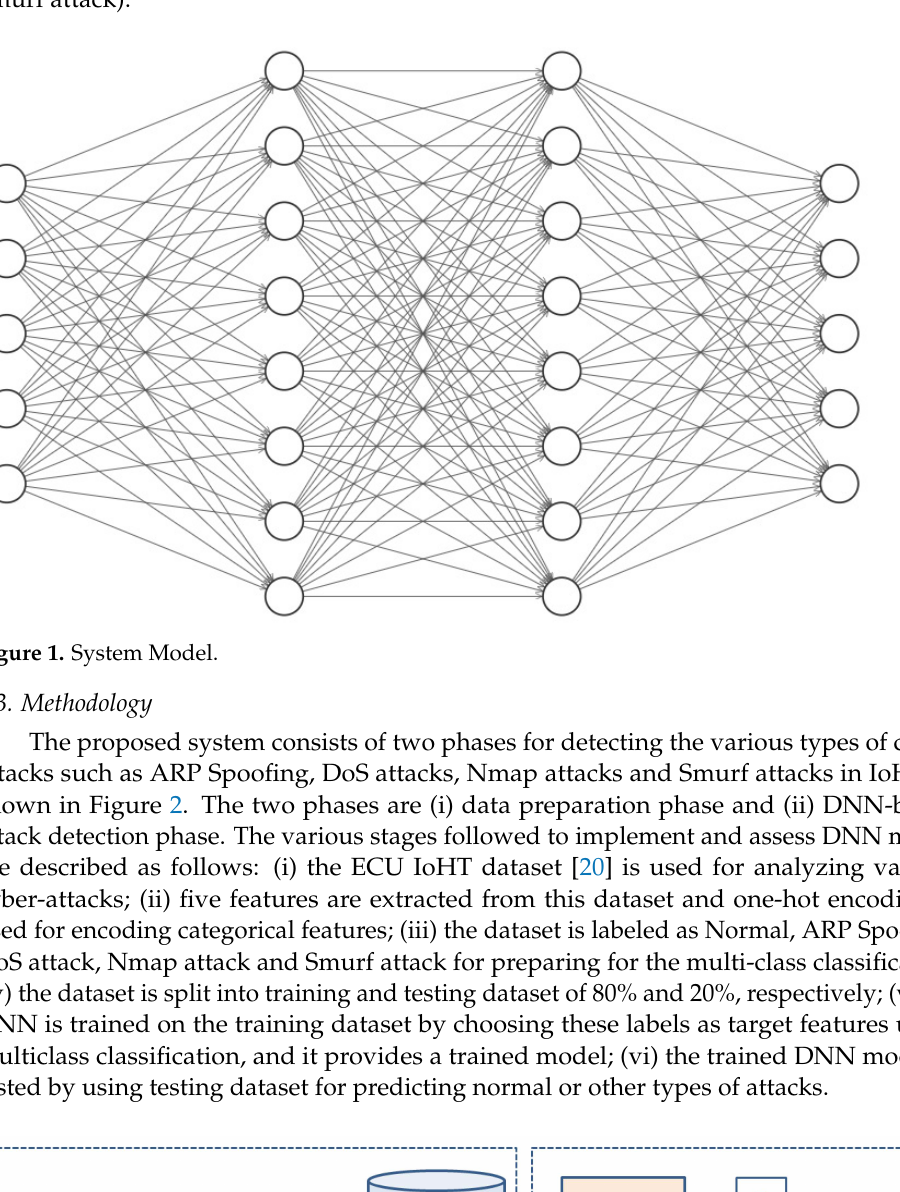
Figure 2. Proposed System .